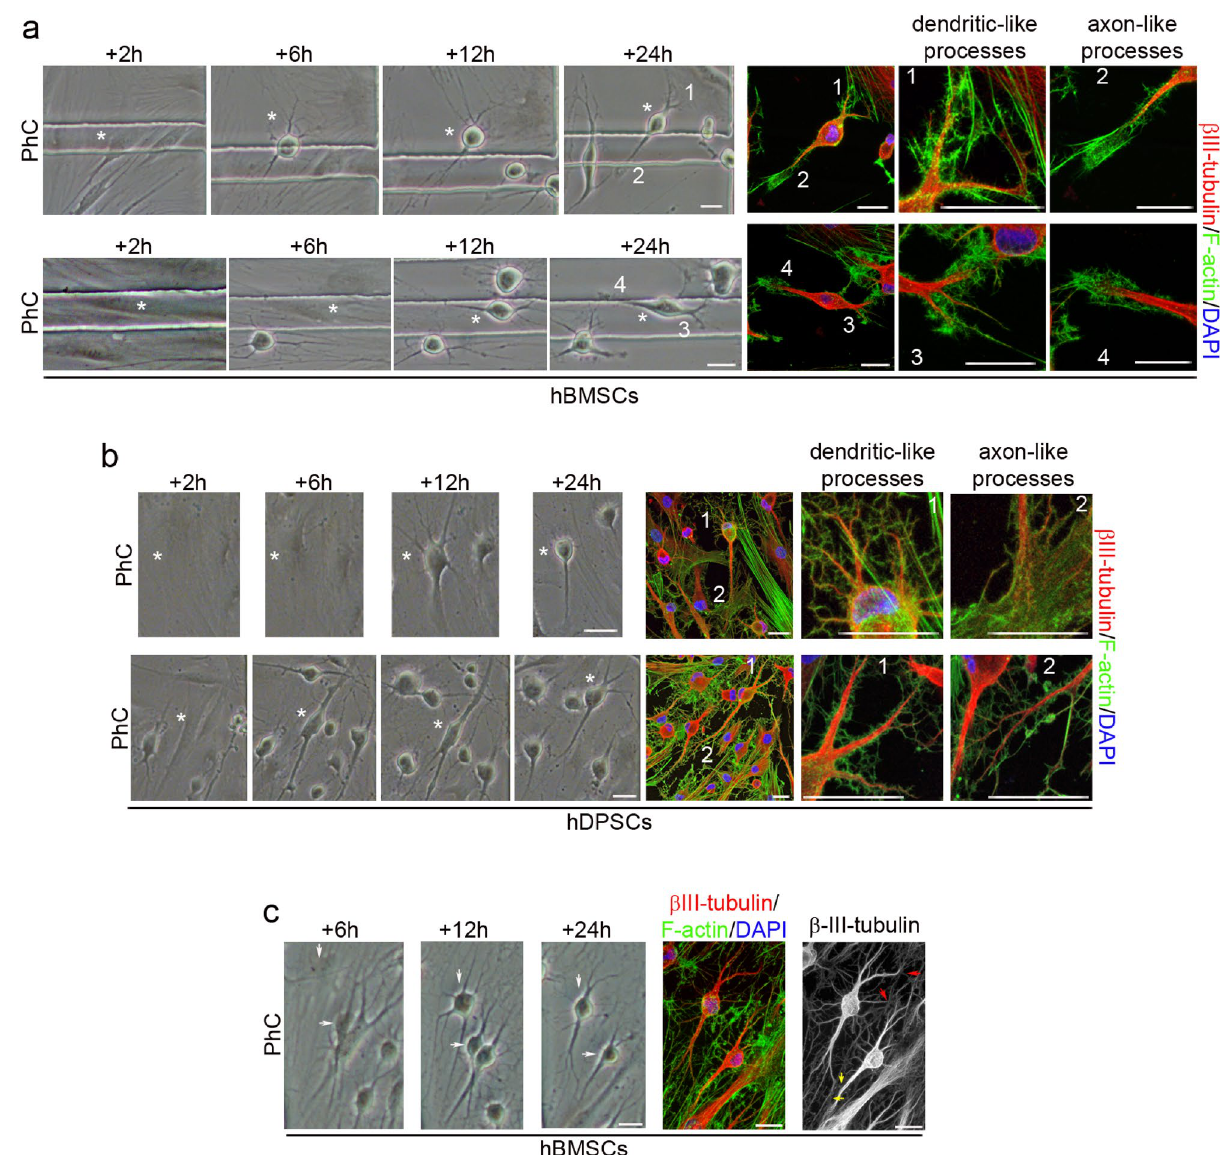
Figure 5. Final stages of neuronal polarisation of hBMSC-derived and hDPSC-derived neuron-like cells. Cytoskeletal protein β-III tubulin and F-actin staining showed that hBMSC-derived ( a ) and hDPSC-derived neuron-like cells ( b ) developed distinct dendrite-like and axon-like domains (numbers correspond to the areas shown in higher magnifications). ( c ) Time-lapse imaging and immunocytochemical analysis also revealed that the hBMSC-derived neuron-like cells connected together through different types of interactions, including dendrodendritic-like contacts (red arrows) and axoaxonic-like contacts (yellow arrows). Scale bar: 25 μm. PhC: Phase-contrast